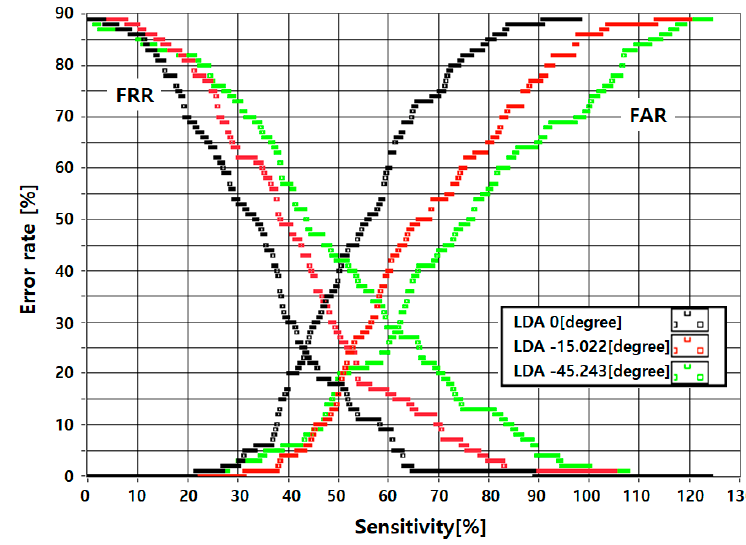
Figure 17. False acceptance rate (FAR)–false rejection rate (FRR) graph at 1790 rpm.